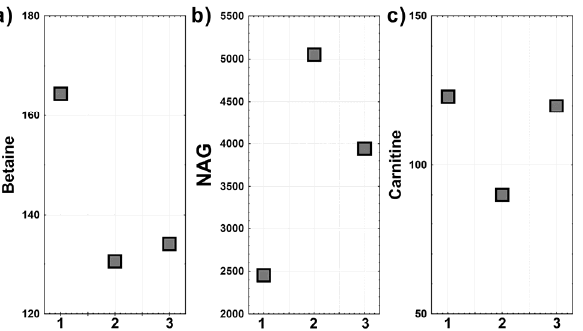
Figure 3. Differences in the relative intensities of betaine ( a ), N-acetyl-glycoprotein ( b ), and carnitine ( c ) among the ALG13 cases: The numbers on the x axis correspond to individual ALG13 patients: 1—Patient 1, 2—Patient 2, and 3—Patient 3.